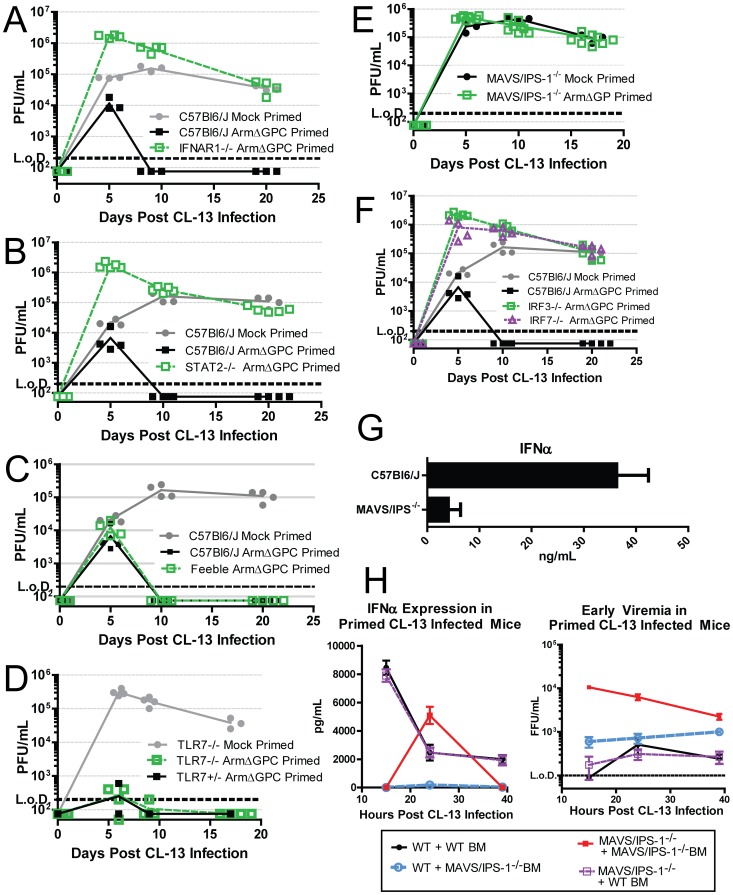
The role of IFN-I during a primed Cl13 infection.A–F) Mice were mock (PBS) primed or ArmΔGPC (2×106,i.v.) primed 12 hours prior to infection with Cl13 (2×106,i.v.). At the indicated times virus titers in serum were determined as in Fig. 1. G) Mice were infected with Cl13 (2×106 ffu, i.v.) and at 24 hours post-infection serum levels of IFNα were measured by ELISA. H) Ly5.1 C57Bl6/J mice and MAVS/IPS-1-/- mice were γ-irradiated and 5×106 bone marrow cells from either Ly5.1 and MAVS/IPS-1-/- were injected i.v. into γ-irradiated mice. Mice were fed antibiotic feed for 5 weeks and 8 weeks post γ-irradiation, mice were primed with ArmΔGPC and infected with Cl13 12 hours later. Serum was taken at the indicated time points and assayed for IFNα by ELISA (left) or plaqued on Vero cells (right) (n = 7/group). All data shown are representative of at least 2 independent experiments.